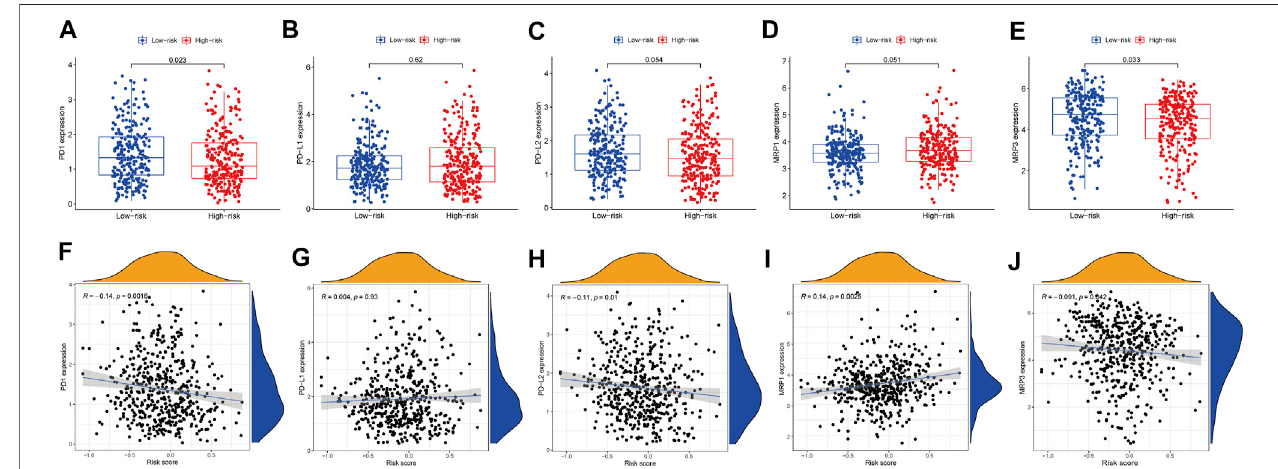
FIGURE7| ThecomparisonoftheexpressionlevelsofPD-1,PD-L1,PD-L2,MRP1andMRP3betweendifferentriskgroupsandcorrelation analysisbetweenrisk score and the expression levels of PD-1, PD-L1, PD-L2, MRP1 and MRP3. (A,F) PD-1. (B,G) PD-L1. (C,H) PD-L2. (D,I) MRP1. (E,J) MRP3.